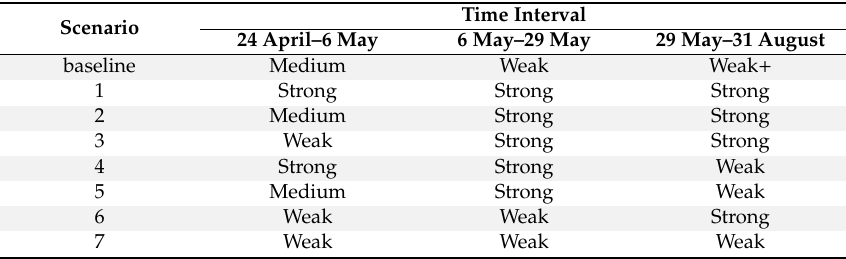
Table 6. Scenarios of social distancing for periods 5-2, 6, and 7.